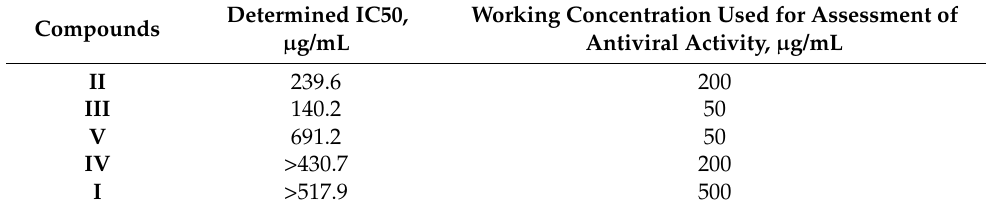
Figure 2. The assessment of the compounds II , III, and V cytotoxicity in cell culture A549. The cell incubation time with the test substances was 24 h—the method for the cytotoxicity assessment, the reduction of tetrazole (MTT assay). Table 1. Active doses of the studied compounds .